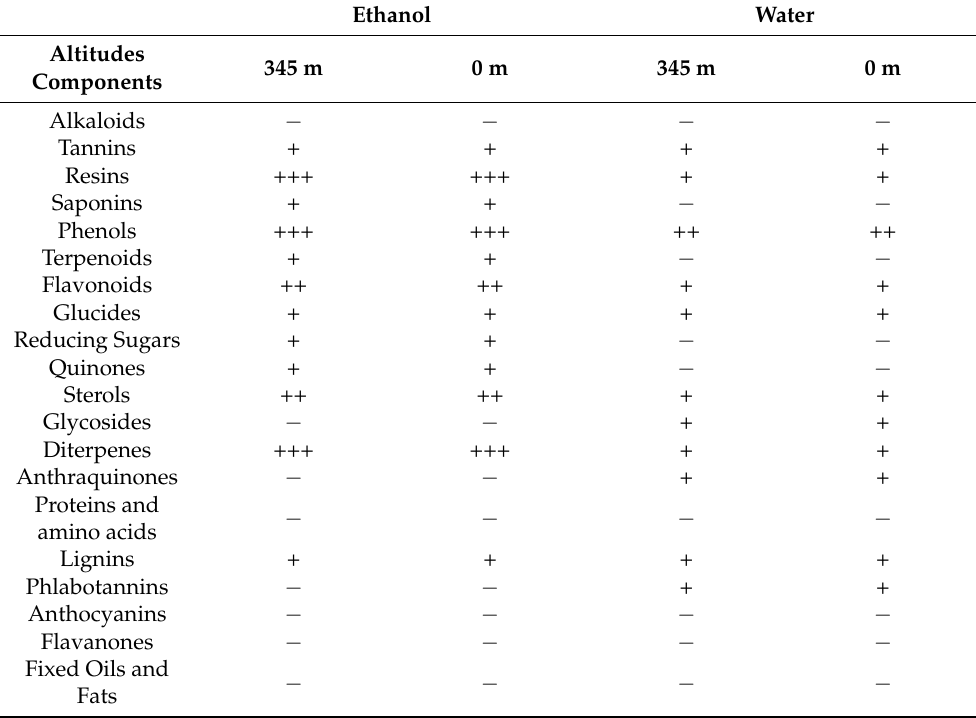
Table 2. Phytochemical screening tests of the ethanolic and aqueous extracts of E. camaldulensis .